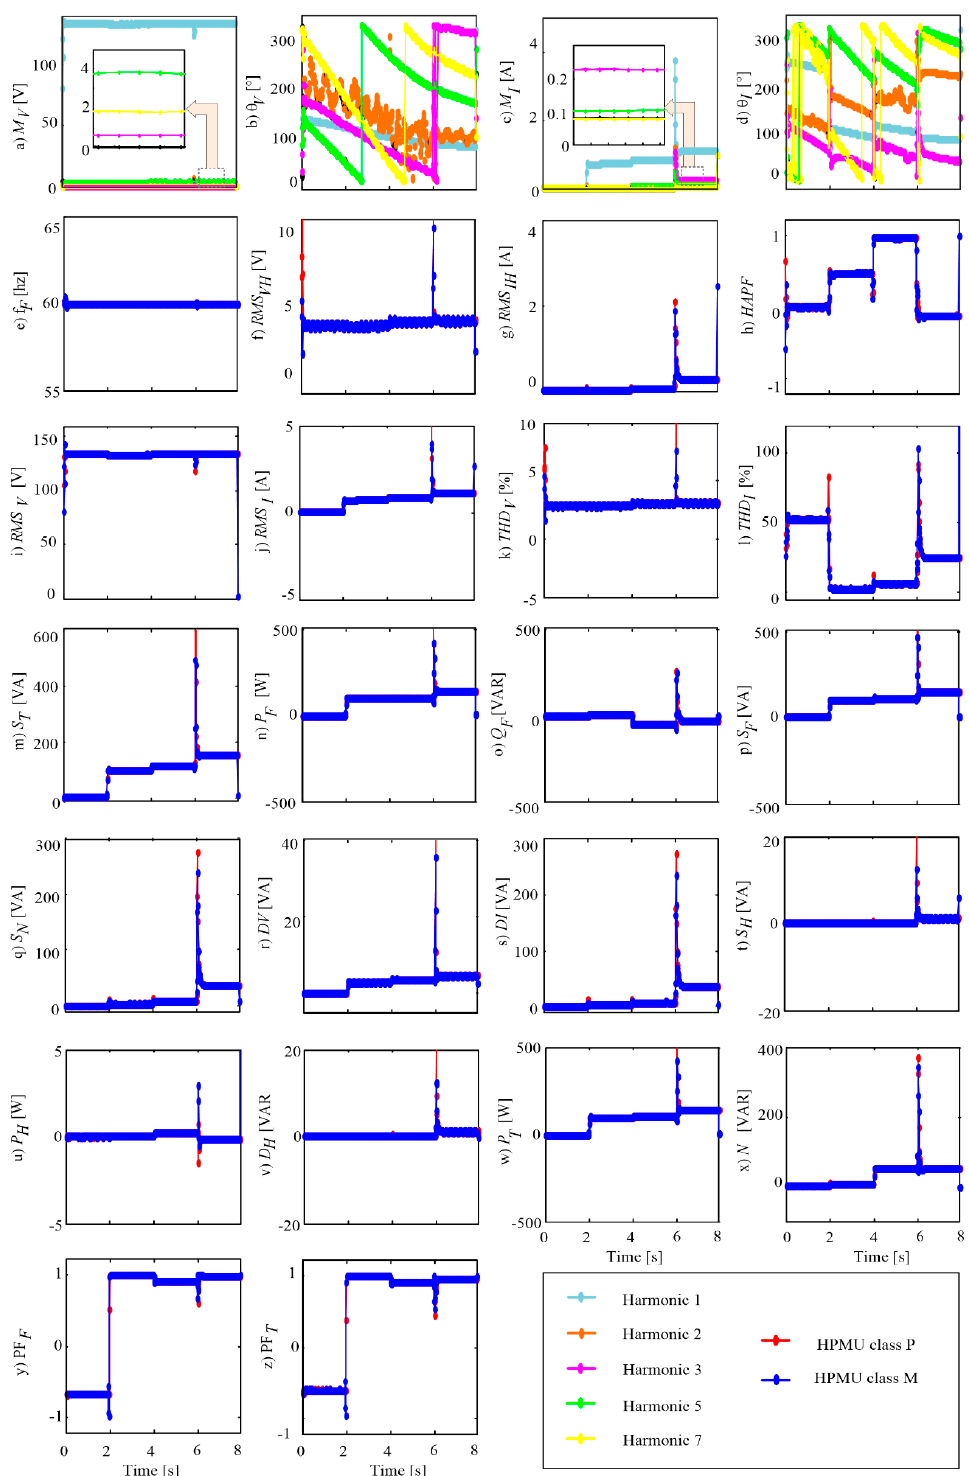
Figure 7. Results for harmonic phasors of voltage and current, global harmonic parameters, and estimation of PQIs: ( a ) M V , ( b ) θ V , ( c ) M I , ( d ) θ I , ( e ) f F , ( f ) RMS VH , ( g ) RMS IH , ( h ) HAPF , ( i ) RMS V , ( j ) RMS I , ( k ) THD V , ( l ) THD I , ( m ) S T , ( n ) P F , ( o ) Q F , ( p ) S F , ( q ) S N , ( r ) DV , ( s ) DI , ( t ) S H , ( u ) P H , ( v ) D H , ( w ) P T , ( x ) N , ( y ) PF F , ( z ) PF T